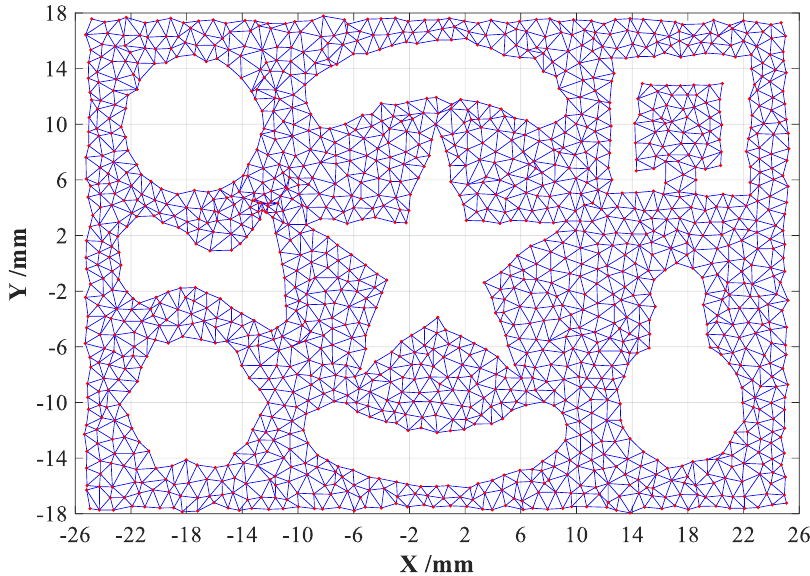
Figure 2. The modified Delaunay triangular meshes (DTMs) for a complex-shape object.